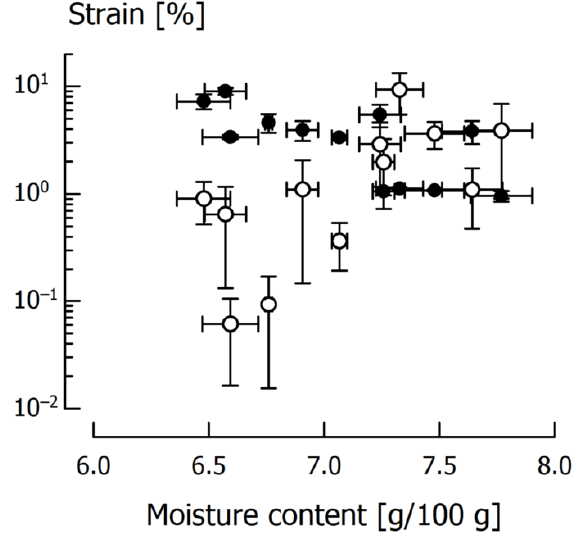
Figure 7. Fracture strain ε f (open circles) and maximum plastic elongation ε p (closed circles) of caramels subjected to tensile testing at 18 °C (all samples showed brittle fracture) and 32 °C (all samples showed ductile behavior), respectively, at v = 1000 mm/min. Data are arithmetic means ± standard deviation for ε f or ε p ( n = 3), and moisture ( n = 3).